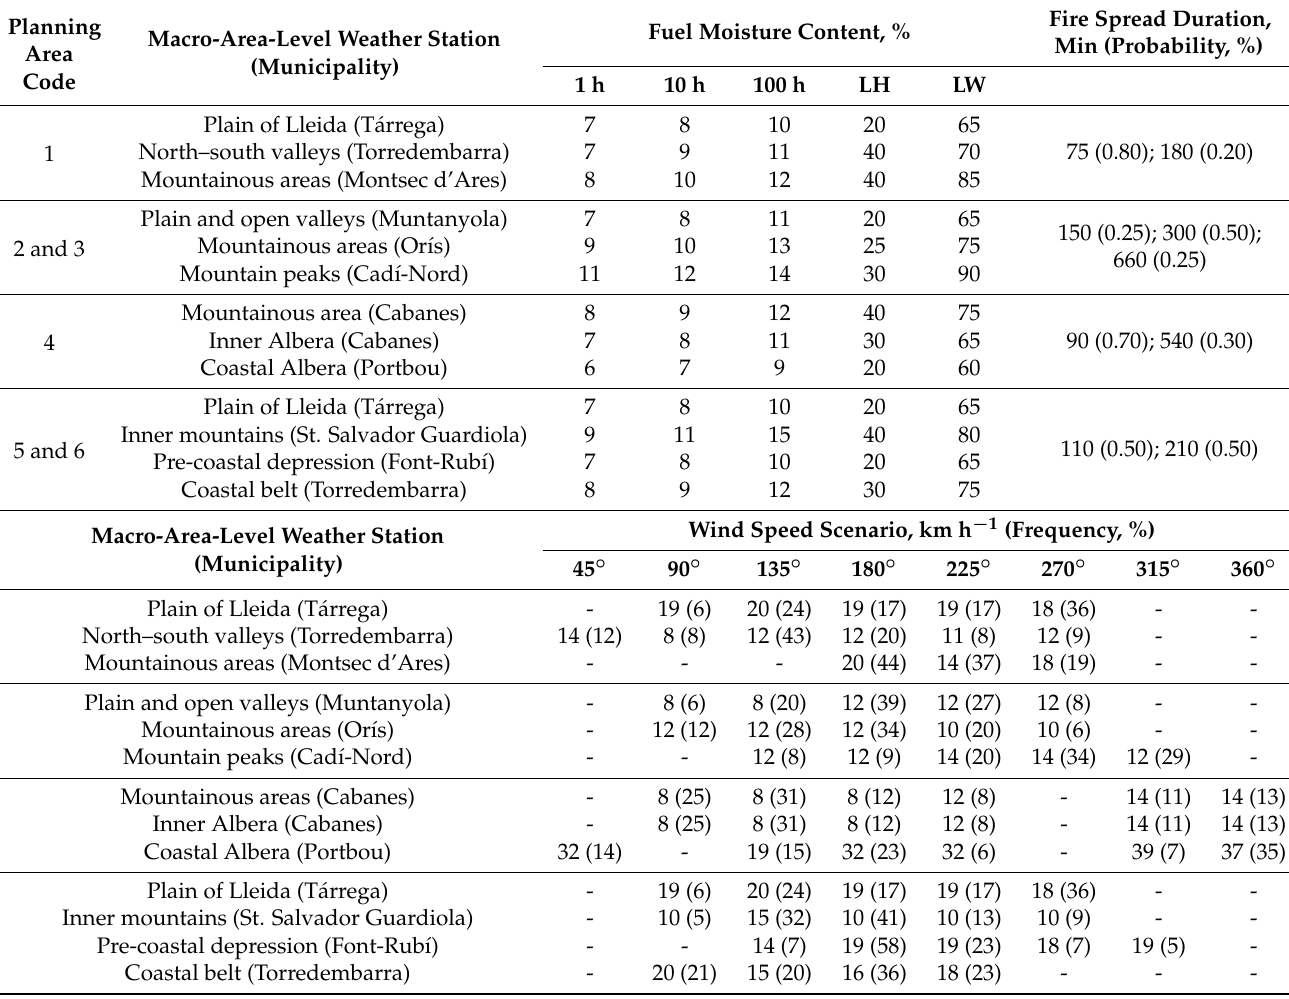
Table 2. Fire-weather scenarios for extreme weather conditions (97th percentile) during wildfire season for the different planning areas. While the neighboring planning areas (Figure 1) were merged in a single fire modeling domain or landscape file, we considered multiple fire weather macro-areas. We used wildfire-season automatic weather station data to generate fire-weather scenarios. We set the fire spread duration probabilities that replicated historic fire distributions under constant extreme fire-weather conditions. See modeled and predicted fire size distributions in Appendix